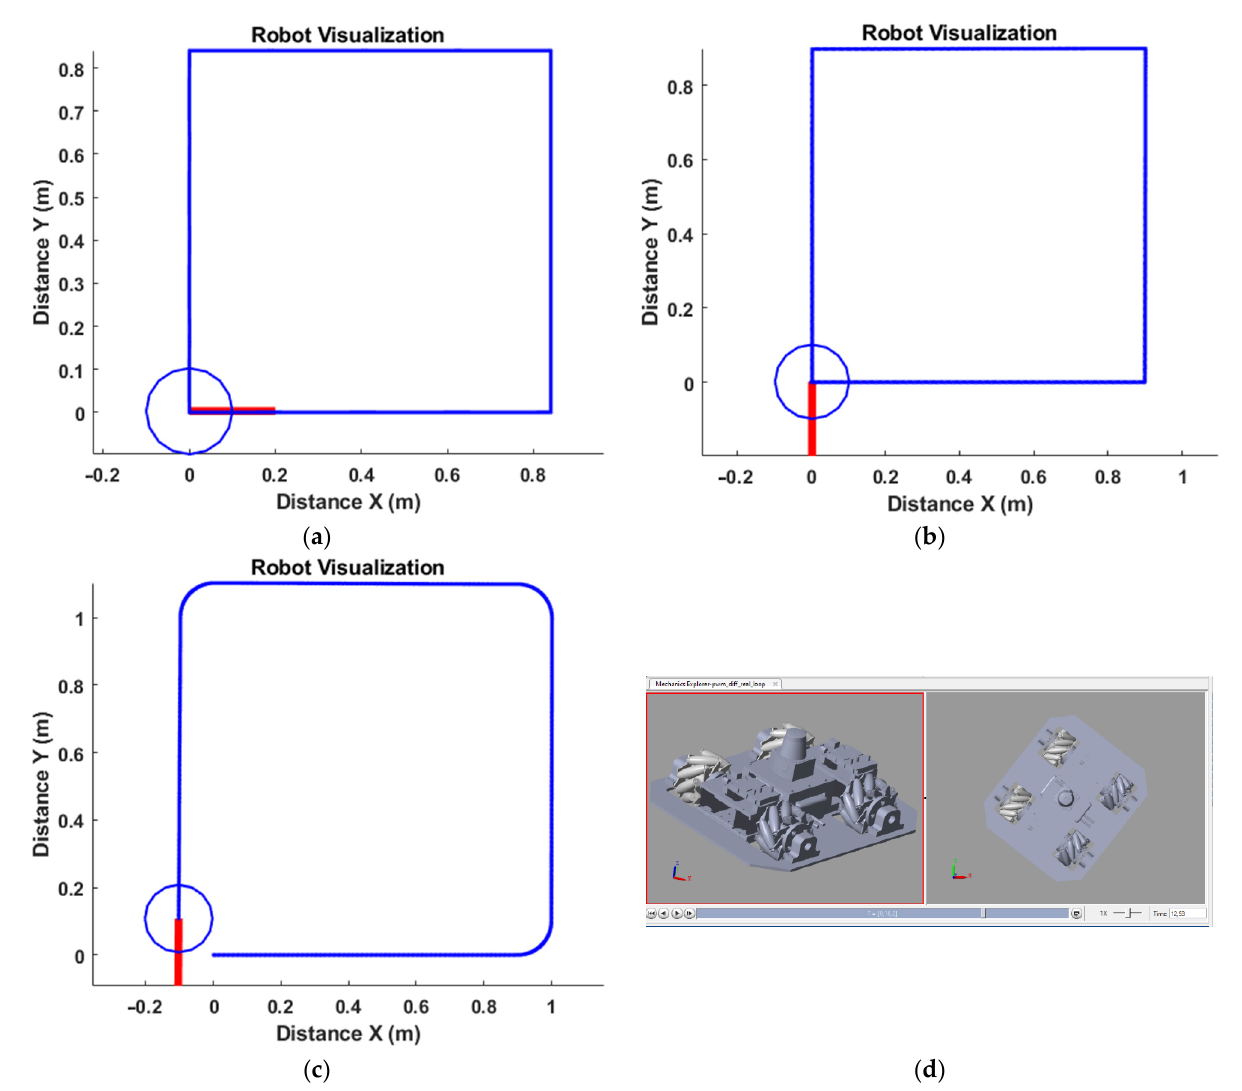
Figure 11. Simulation results: ( a ) trajectory for four-wheel Mecanum; ( b ) trajectory for differential drive, no-loop; ( c ) trajectory for differential drive with loop; ( d ) screenshot from Mechanics Ex- plorer–Simscape.